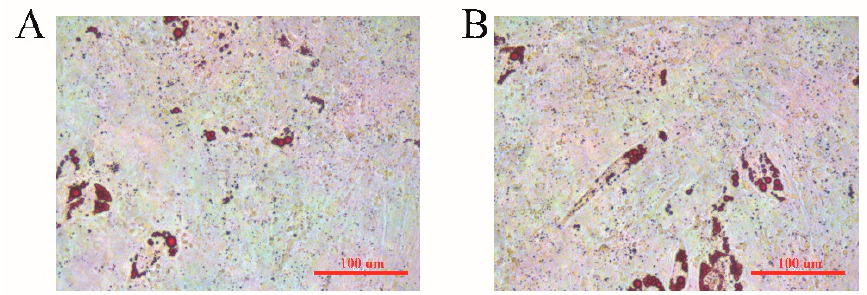
Figure 4. Oil Red O staining when overexpressing the BMP2 gene in sheep preadipocytes after 7 days of induced differentiation. (A) Control group. (B) BMP2 overexpressed group.